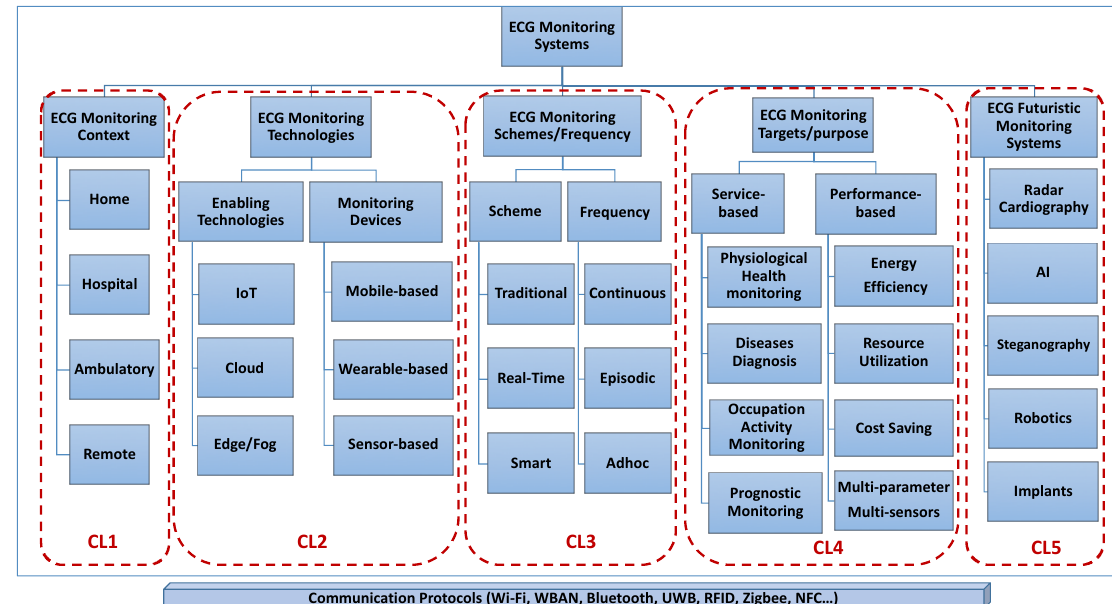
Figure 3. ECG monitoring system clustering.